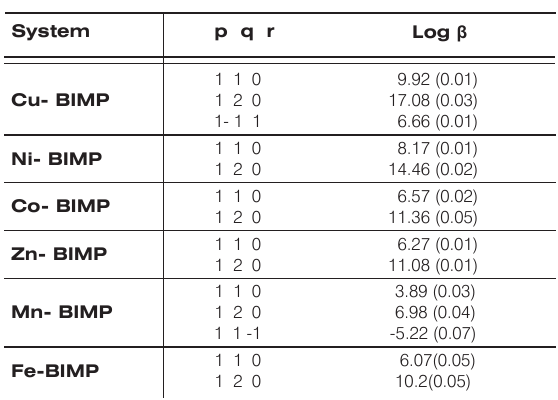
Formation constants of metal complexes with BIMP (BIMP) H at 25 o C and complexes of general formula M p q r Table 6) are exothermic ( D H o = -22.15, -14.43 and 0.1 M NaNO . 3 -11.92 kJ mol -1 ), as expected for neutralization reactions.